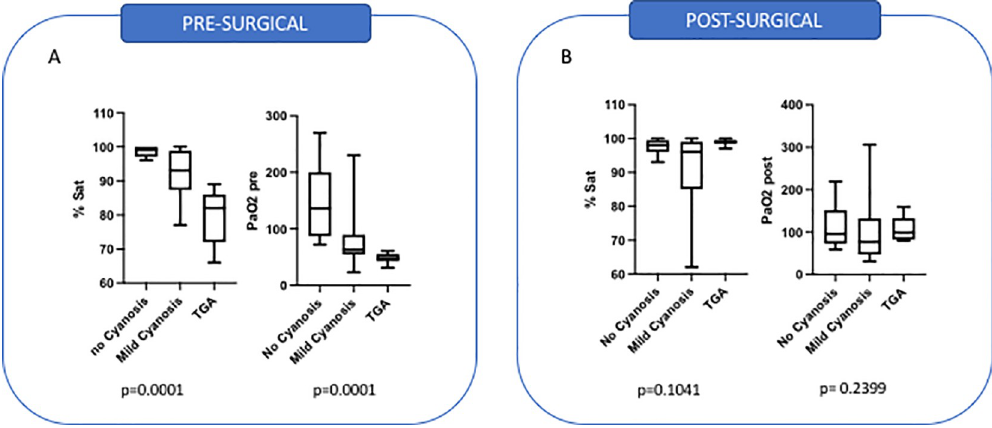
Fig 1. A : Pre-surgical levels of hemoglobin saturation and paO2. B: Post-surgical levels of hemoglobin saturation and paO2.